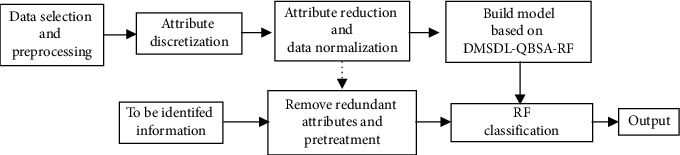
Block diagram of the oil layer classification system based on DMSDL-QBSA-RF.